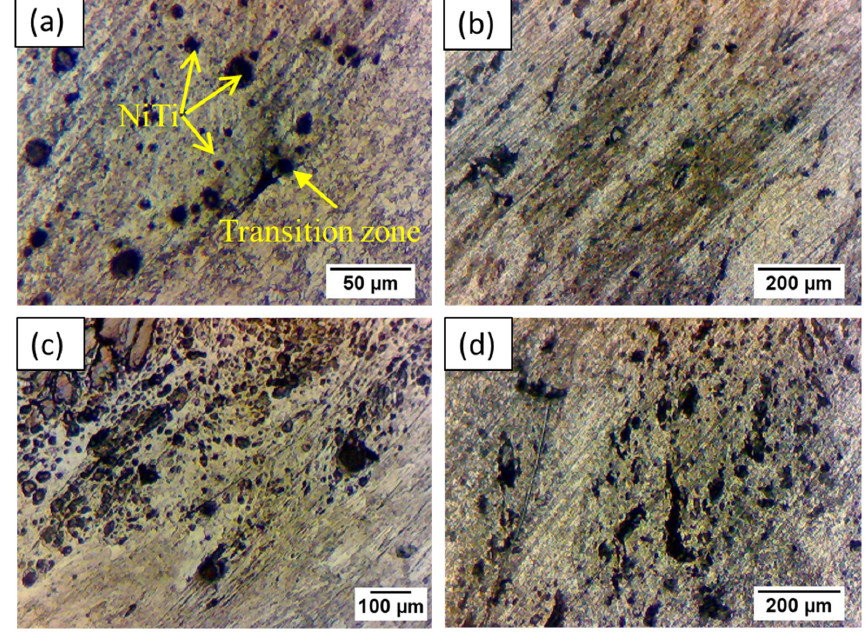
Figure 9. LM images showing the composited regions of ( a ) specimen 1, ( b ) specimen 2, ( c ) specimen 3, and ( d ) specimen 4.